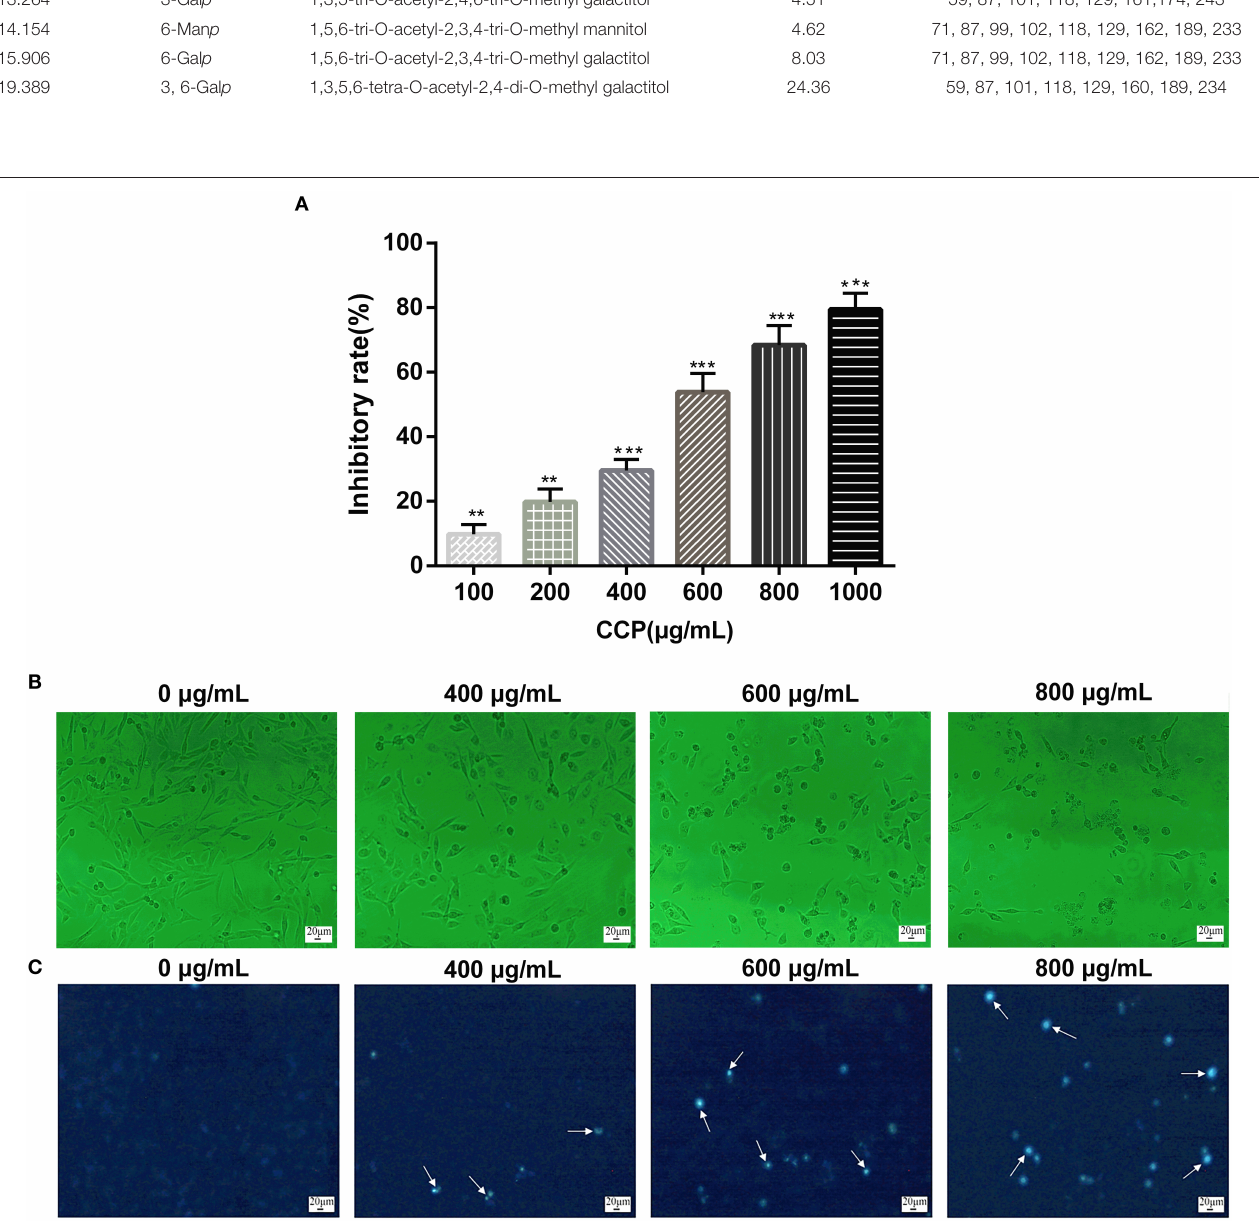
Frontiers in Nutrition |